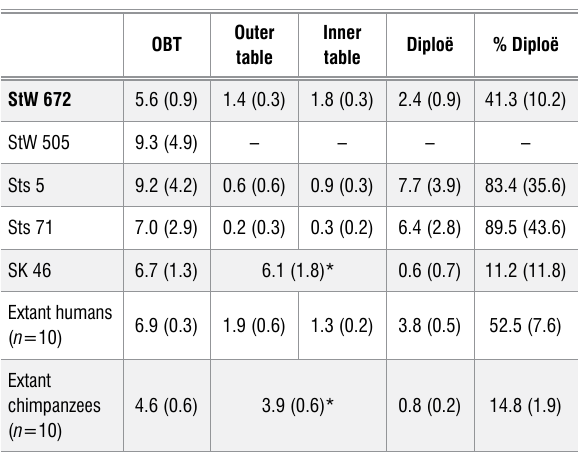
Mean occipital bone thickness (OBT, mm) and relative proportions of the diploë (%) of StW 672 compared to the estimates from some Plio-Pleistocene hominin specimens and extant humans and chimpanzees. Standard deviations are shown in